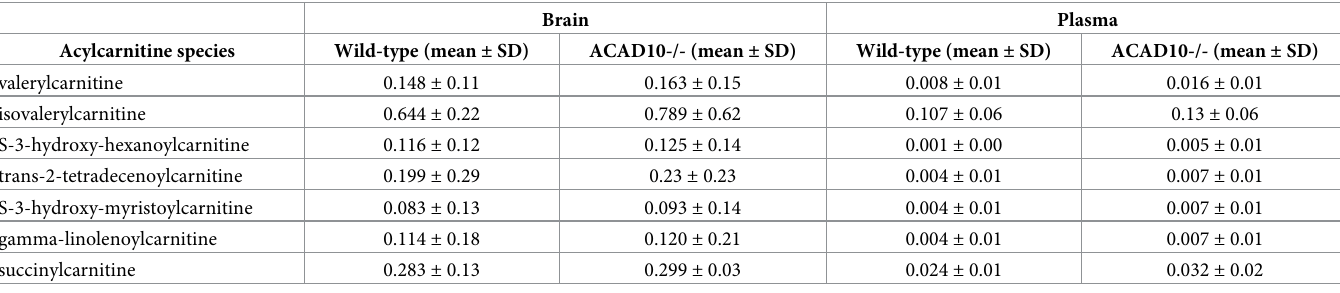
Table shows means ± standard